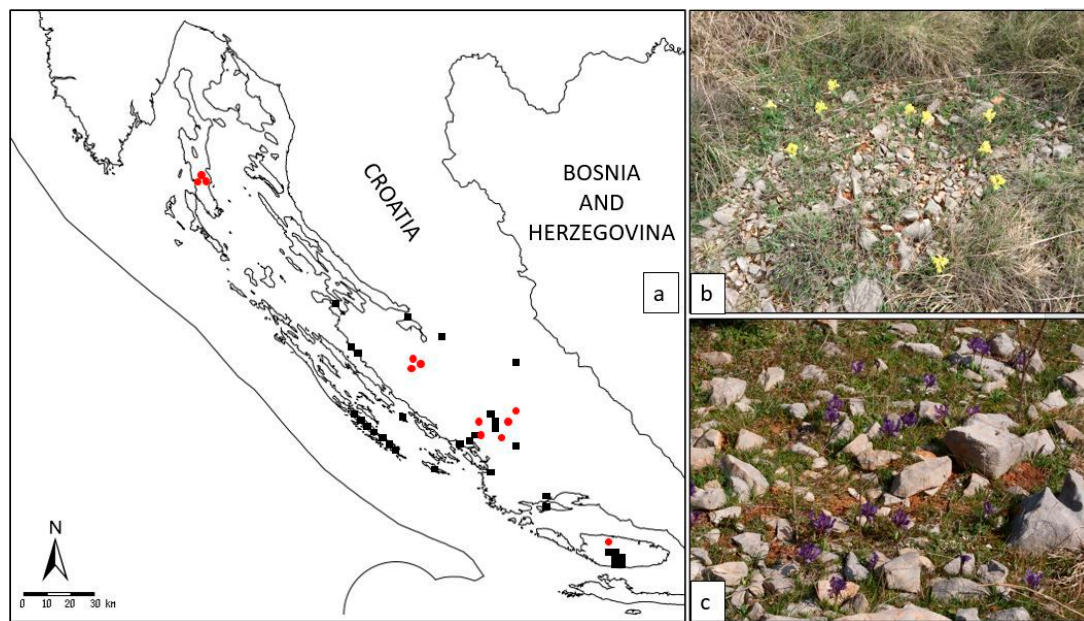
Figure 2. ( a ) Distribution map of the narrow endemic Alpine-Dinaric species Iris adriatica included in our study (all localities are in Croatia, and are incorporated in the national Flora Croatica Database (https://hirc.botanic.hr/fcd ) —FCD; marks: —earlier data from the FCD; —localities of collected specimens in our study); ( b ) habitat on the locality Brnjica-Pokrovnik; ( c ) habitat on the island of Cres. I. adriatica (Figure 1a–c) is a narrow endemic plant from the I. pumila complex, characterised by